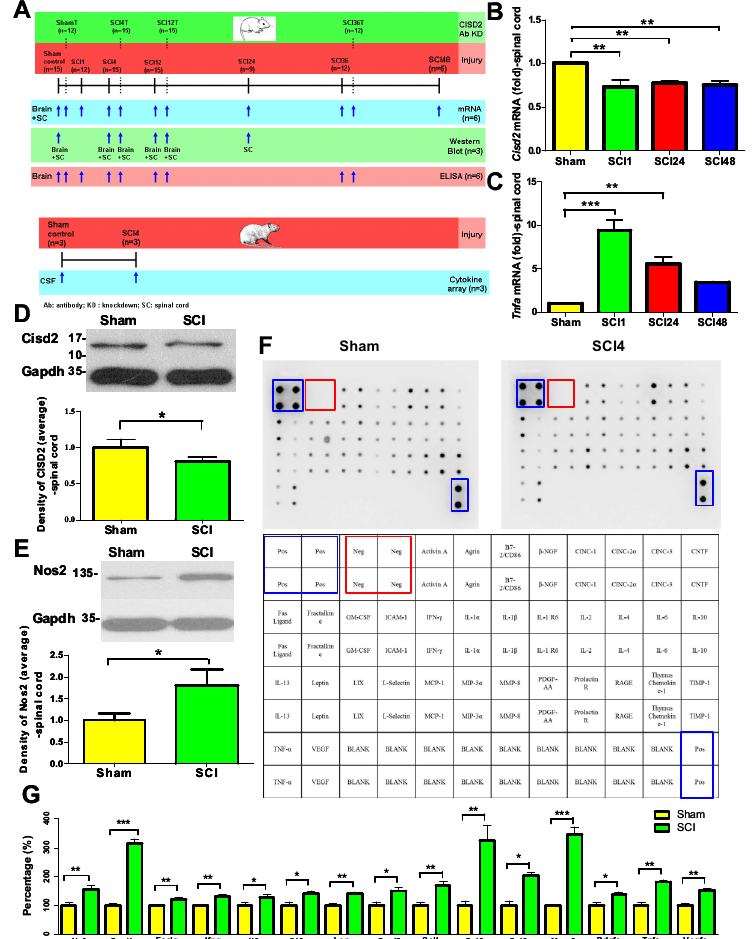
Figure 2. Spinal cord injury (SCI) downregulates Cisd2 and enhances inflammatory response in the injured spinal cord of mice subjected to spinal cord hemisection. The secretion of various inflammatory mediators in the cerebrospinal fluid (CSF) of rats with SCI. ( A ) Experimental groups and the schedule of treatment with anti-CISD2 antibody in a mouse model of SCI. ( B ) The spinal cord levels of Cisd2 mRNA in the 1, 24, and 48 h post-SCI groups were significantly decreased compared with those in the sham operation group. ( C ) Under the same conditions as those in ( B ), the spinal cord levels of Tnfa mRNA were significantly increased. For B and C, vertical bars indicate mean ± standard error of mean (SEM) ( n = 6 for each group). * p < 0.05, ** p < 0.01, and *** p < 0.001 (pair-wise multiple comparisons between groups were performed using the Newman–Keuls test). The spinal cord levels of the Cisd2 protein were decreased ( D ) and those of Nos2 were increased ( E ) in the 24 h post-SCI group compared with those in the sham operation group. For D and E, the upper panel indicates representative immunoblot of the protein expression of Cisd2 (15 kDa) ( D ) and Nos2 (135 kDa); ( E ) Gapdh (35 kDa) was used as an internal control. For ( D ) and ( E ), vertical bars indicate mean ± SEM of protein levels ( n = 3 for each group). * p < 0.05, sham operation group vs. SCI groups (independent two-sample t -tests). ( F ) Detection of inflammatory mediators in the CSF using the cytokine antibody array at 4 h post-SCI in rats. Representative image of the array assay demonstrating the reactivity of pooled CSF samples (upper left panel, sham operation group; upper right panel, SCI group at 4 h post-SCI). n = 3 for each group with two replicates for each protein target. Signals were scanned with ImageQuant TM LAS 4000 (GE Healthcare Life Science, Marlborough, MA, USA). Blue box, positive controls (high intense spots); red box, negative controls (no spots); lower panel, schematic illustration of the location of positive (blue box), negative control (red box), and 34 targets. ( G ) Signal intensity of inflammatory mediators in the CSF of the sham operation and SCI groups was comparatively analyzed. Vertical bars indicate mean ± SEM of protein levels ( n = 3 for each group). * p < 0.05, ** p < 0.01, and *** p < 0.001 (sham operation group vs. SCI groups; independent two-sample t